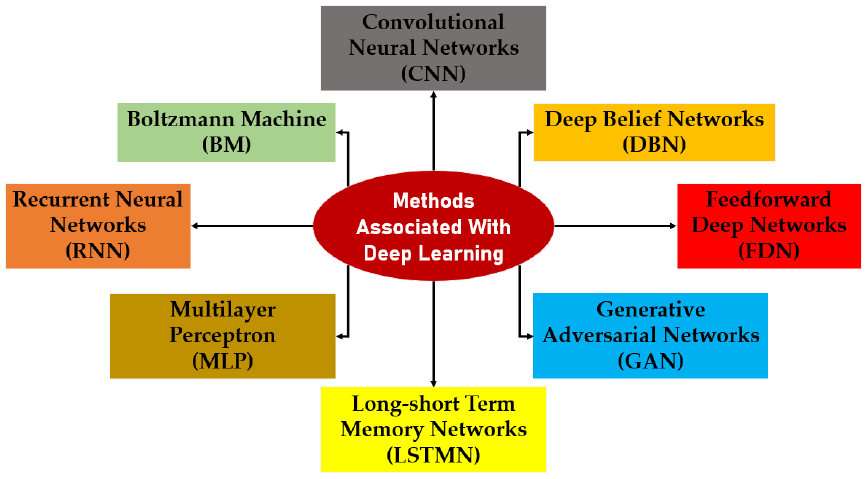
Figure 15. Methods associated with deep learning.